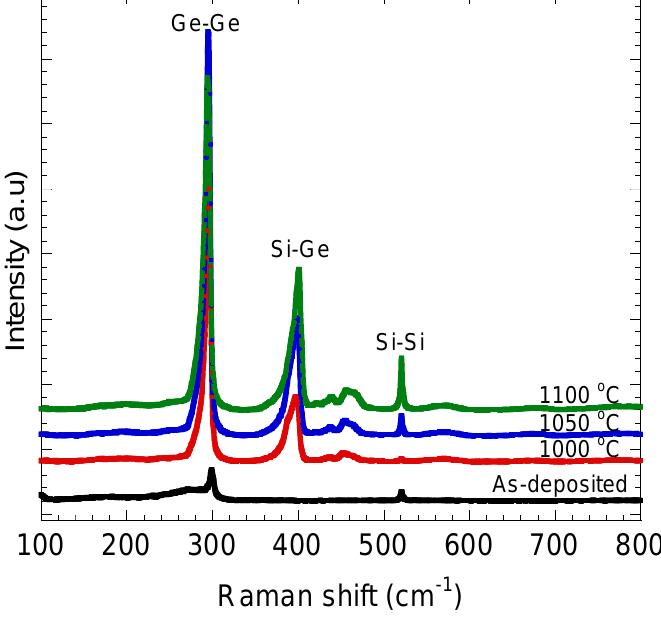
Figure 3. Typical Raman spectra of annealed Ge/Si at different